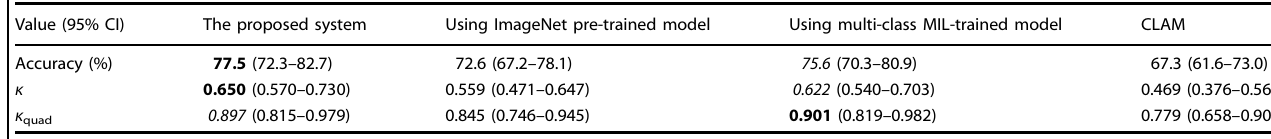
Table 2. Performance indices of the proposed system and baseline methods.